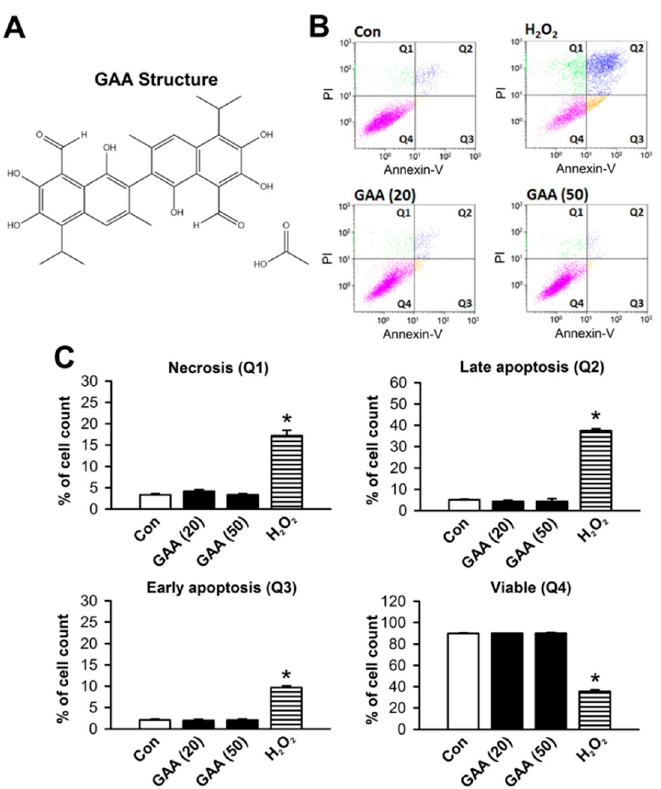
Figure 4. GAA does not induce cell death in neonatal rat cardiomyocytes. ( A ) The chemical structure of GAA. ( B ) GAA did not induce apoptosis and necrosis according to analysis by flow cytometry of Annexin V-FITC/PI double staining at 24 h. H 2 O 2 was used as a positive control. ( C ) Statistical analysis of necrosis (Q1), late apoptosis (Q2), early apoptosis (Q3), and viability (Q4) in neonatal rat cardiomyocytes (n = 4). The same experimental group was assessed by repeating cell culture four times. All data represent means ± SEM. * p < 0.05 versus the control group. Con, control; GAA, gossypol acetic acid; H 2 O 2 , hydrogen